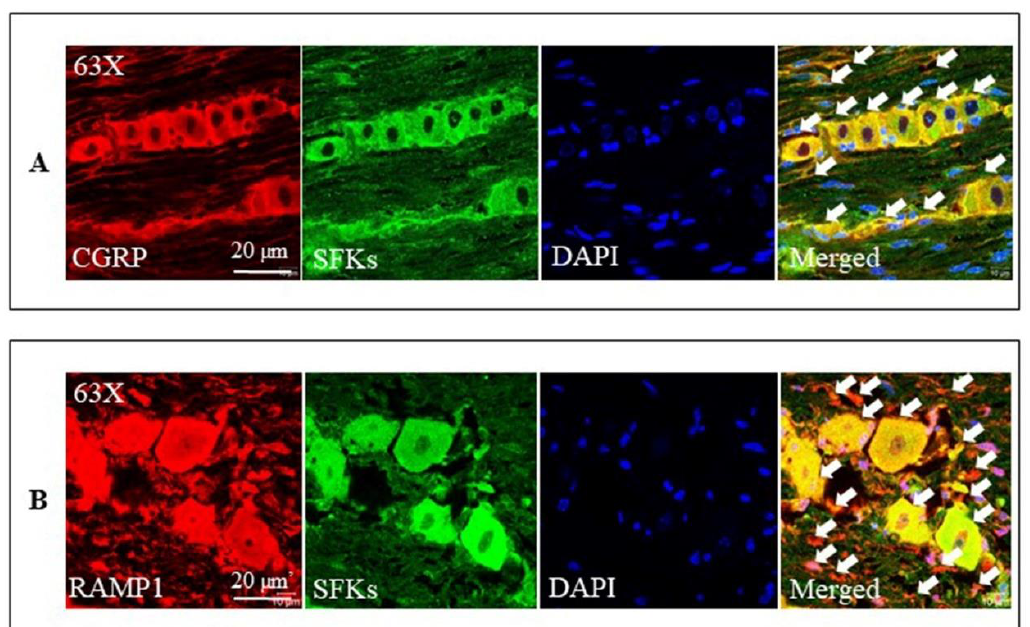
Figure 8. SFKs co-localized with both CGRP and RAMP1 in the mouse TG. ( A ) The representative images of double staining with the anti-CGRP antibody and anti-SFKs antibody in the TG. ( B ) The representative images of double staining with the anti-RAMP1 antibody and anti-SFKs antibody in the TG. CGRP and RAMP1 were stained with the anti-CGRP antibody and anti-RAMP1 antibody, respectively, and are shown in red; SFKs were stained with the anti-SFKs antibody and are shown in green; nucleus was stained with DAPI and is shown in blue. Co-localization of SFKs and CGRP or RAMP1 is shown in yellow and is indicated by the white arrows.